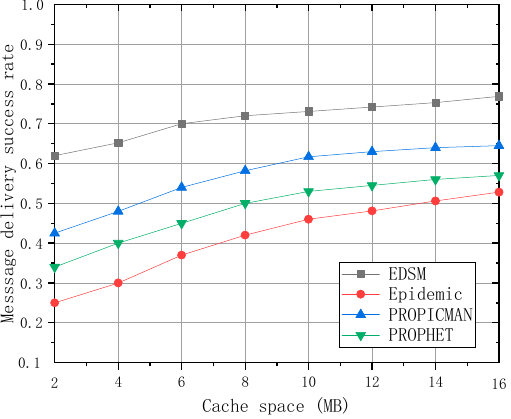
Figure 7. Message delivery success rate in different cache.